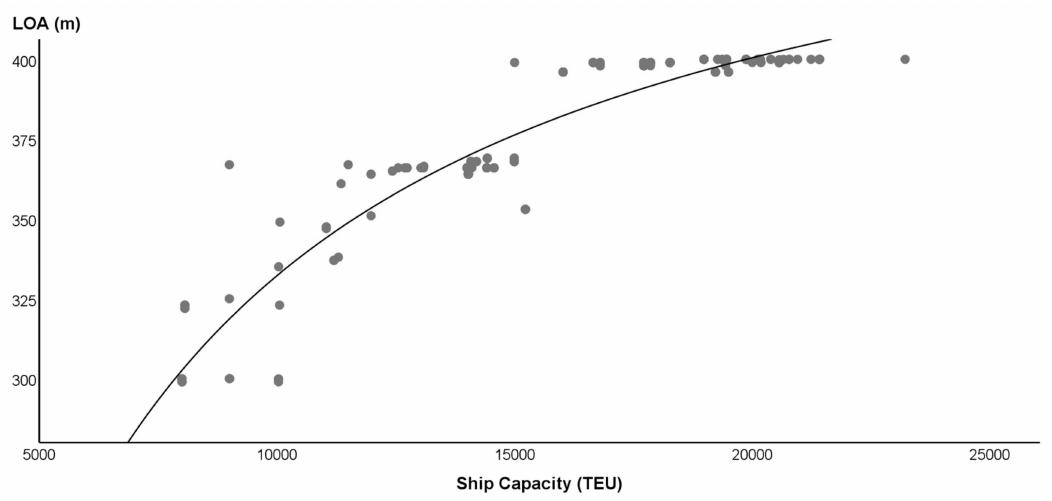
Figure 1. Regression Curve between Ship Capacity and LOA.